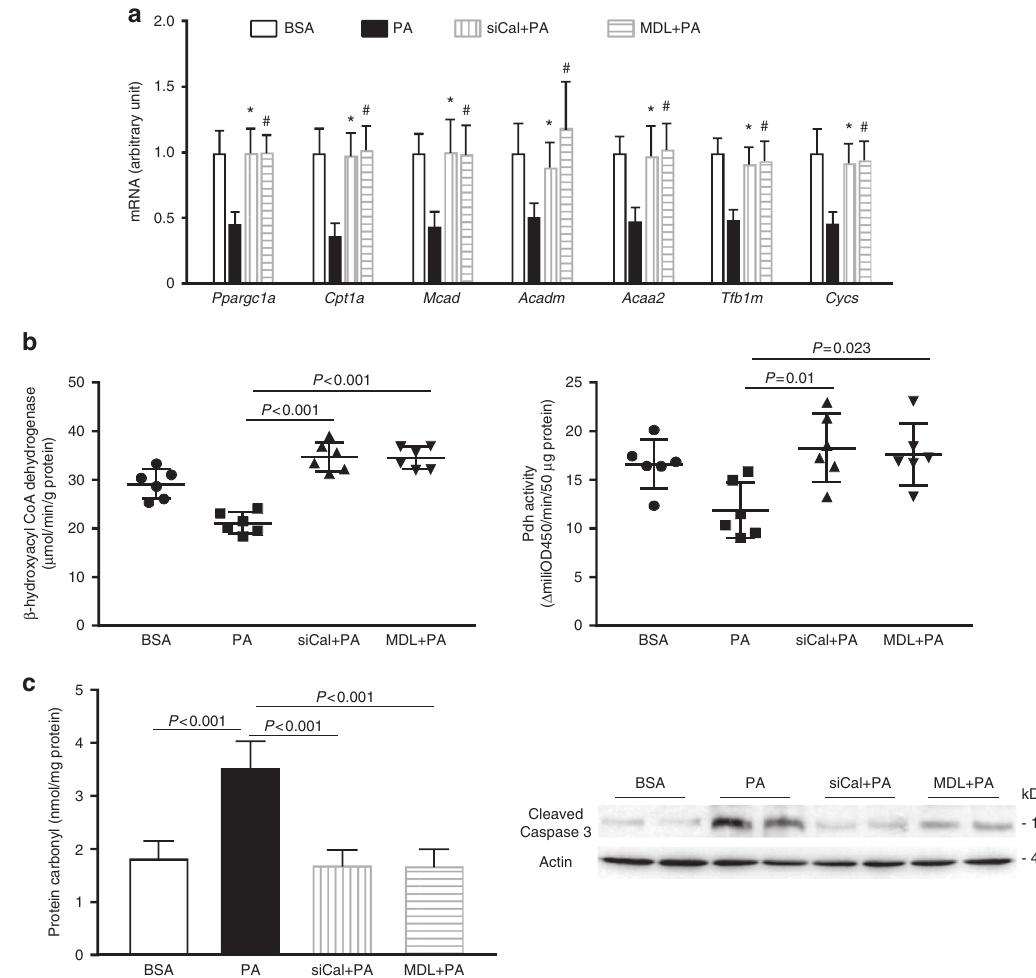
Fig. 7 Prevention of Erk5 degradation rescued mitochondrial functions in ARCMs. a Prevention of Erk5 reduction by calpain-1 knockdown or MDL-28170 (30 µ M for 16 h) was able to retrieve the mRNA level of key mitochondrial genes reduced by 8 h PA treatment. * or # P < 0.05, vs. PA-treated group. b Mitochondrial oxidation activities of β -hydroxylacyl CoA dehydrogenase and pyruvate dehydrogenase (Pdh) were restored when calpain-1 was blocked. c FFA-induced oxidative damage was ameliorated followed by calpain-1 knockdown or inhibition, indicated by decreased protein carbonyl amount or active caspase-3 expression, respectively. n = 6 independent experiments per group. Actin is the protein loading control. Data are presented as means ±